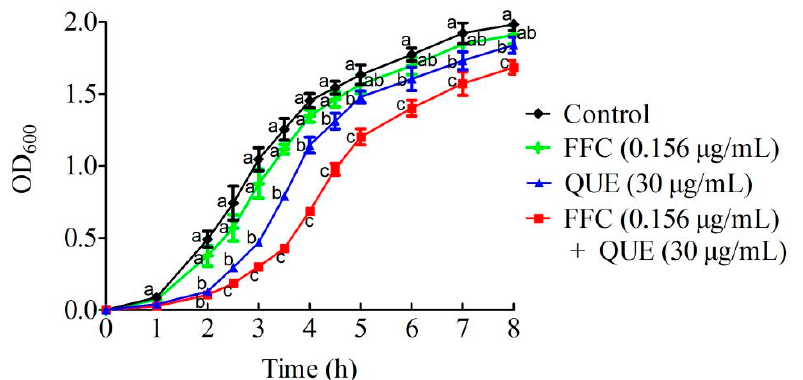
Figure 3. The growth curve of A. hydrophila treated with quercetin and florfenicol either alone or in combination. Untreated cells were used as control. QUE, quercetin; FFC, florfenicol.